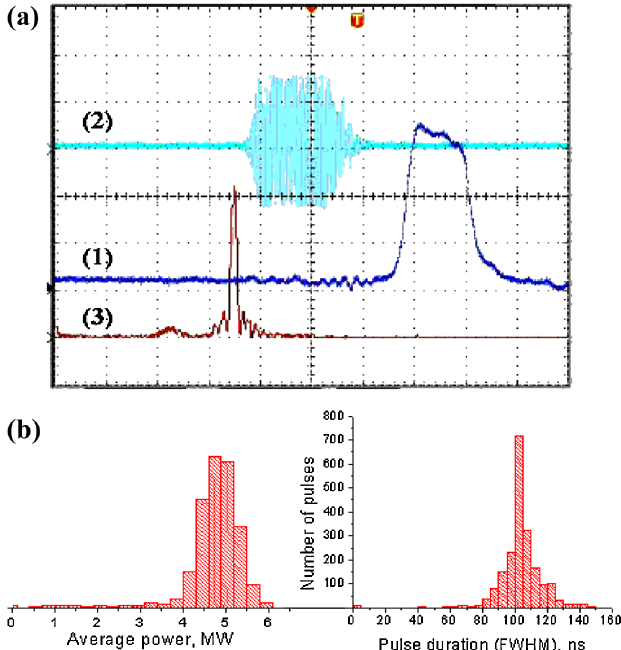
FIG. 2. (a) Typical oscilloscope traces of (1) rf pulse ( 100 ns = div ), (2) heterodyne beat signal, and (3) frequency spec- trum ( 50 MHz = div ). (b) Statistic distributions of pulse duration and rf power after the test cavity in the series of 10 4